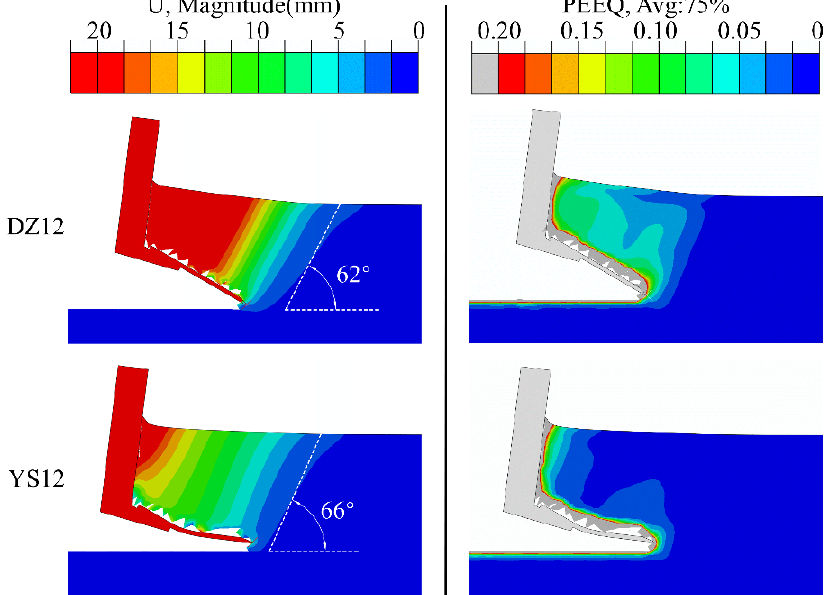
Figure 13. Soil failure of run No. 12. Displacement contour plot (left) and equivalent plastic strain contour plot (right).